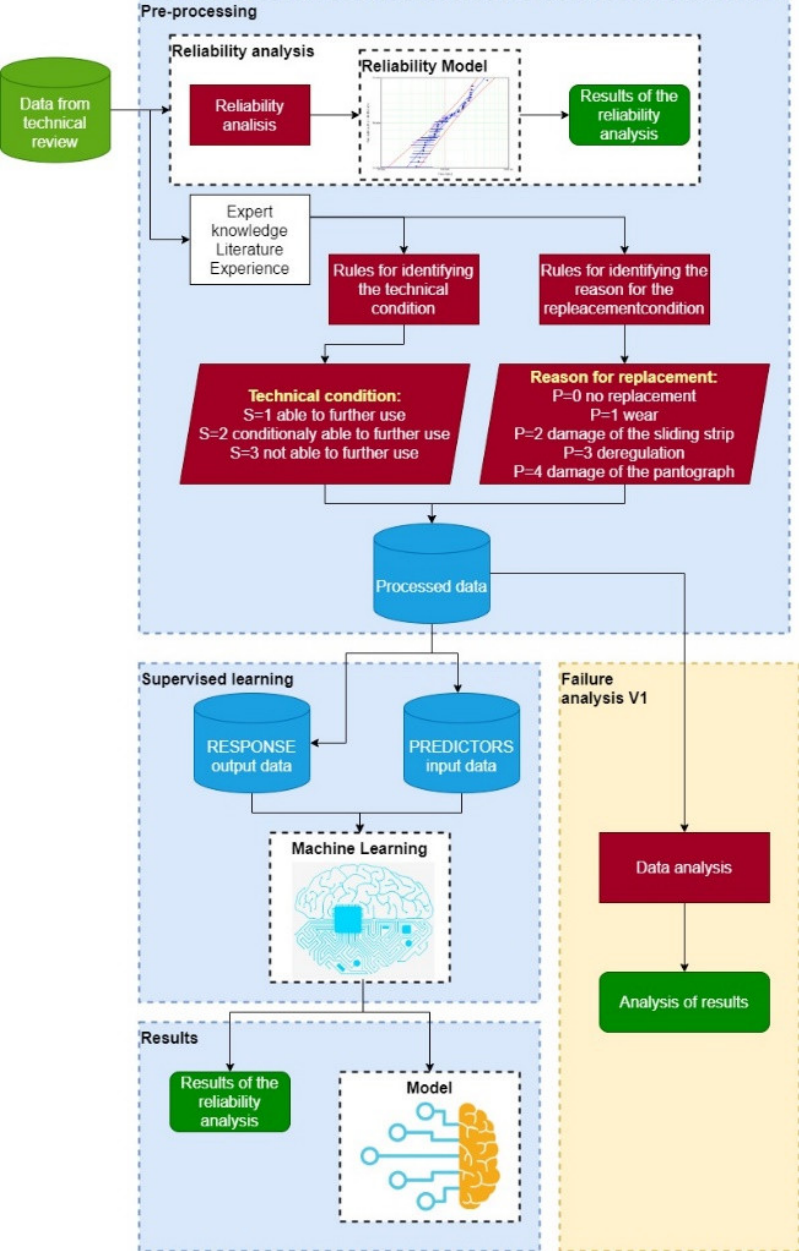
Figure 3. Method of three-valued prediction of technical condition based on machine learning and failure analysis for the reference variant—step 1.